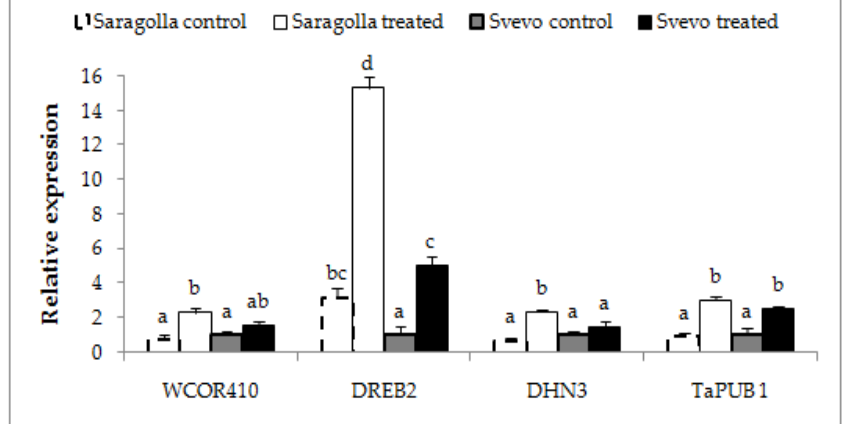
Figure 8. qRT-PCR analysis of DREB2, DHN3, WCOR410, and TaPUB1 genes in Svevo and Saragolla roots subjected to osmotic stress. Seven days-old Saragolla and Svevo seedlings were subjected to osmotic stress treatment for 5 days, by means of 18% PEG-6000 administration. At the end of the treatment, total RNA was extracted and the qRT-PCR analysis of relative expression of DREB2 , DHN3 , WCOR410 and TaPUB1 , performed as described in Section 4.7. The results represent the mean values ± SD of three independent experiments. Statistical significance was attributed by one-way ANOVA test. Bars labeled with dissimilar letters are significantly different ( p < 0.05). Table 2. Differentially represented proteins in roots of Svevo and Saragolla seedlings subjected to osmotic stress. Protein extracts from roots of control or treated with 18% PEG-6000 for 5 days; Svevo and Saragolla seedlings were separated by 2DE and analyzed by LC/MS/MS nano LC-ESI-LIT- MS/MS, as described in Section 4.8. Spot number, protein name, NCBI entry, together with the corresponding fold change between control and PEG-6000 treated samples in the two varieties, are reported. Values in black: Up-regulated proteins. Values in blue: Down-regulated proteins. Values in red: non-differential proteins. Statistical significance was attributed by Student’s test ( p <